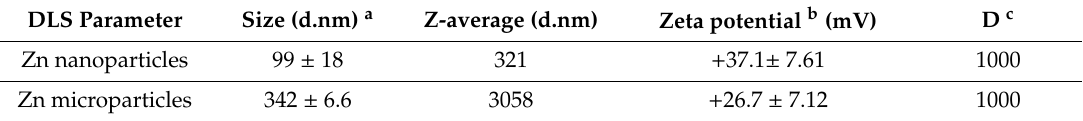
Table 1. Dynamic light scattering technique (DLS) results for obtained zinc particles.